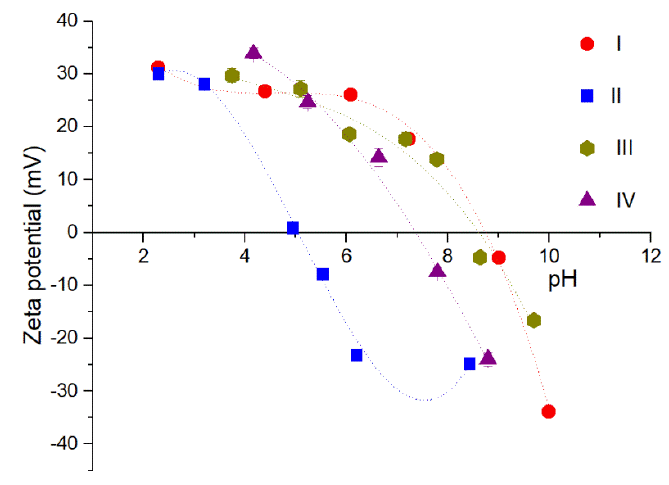
Figure 4. Zeta potential behavior of sample BSHF-Si-30APTES in four batches (I–IV).